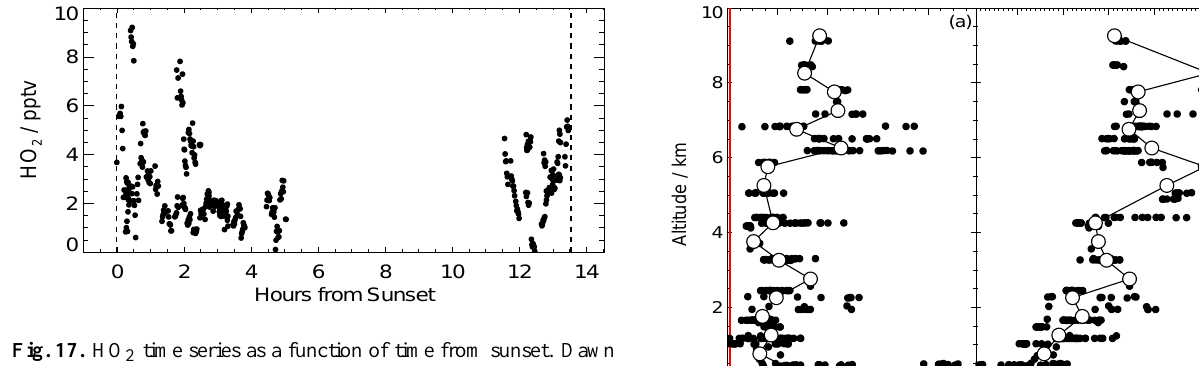
Fig. 17. HO 2 time series as a function of time from sunset. Dawn and dusk are indicated by dashed lines.